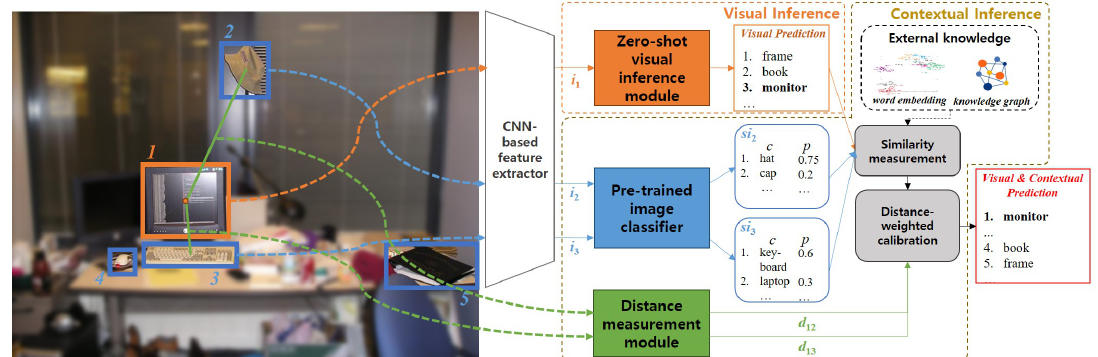
Figure 1. The architecture of our proposed model with an example in an office environment. The model performs Zero-Shot Recognition (ZSR) on two main branches: the instance-level visual inference and the contextual inference.The visual inference first infers the class label of the extracted feature vector i 1 of the target object, which is a process used by existing methods. A distance-weighted, similarity-based calibration is then performed between the target and its surrounding objects to refer to the contextual information, which is the novel process we